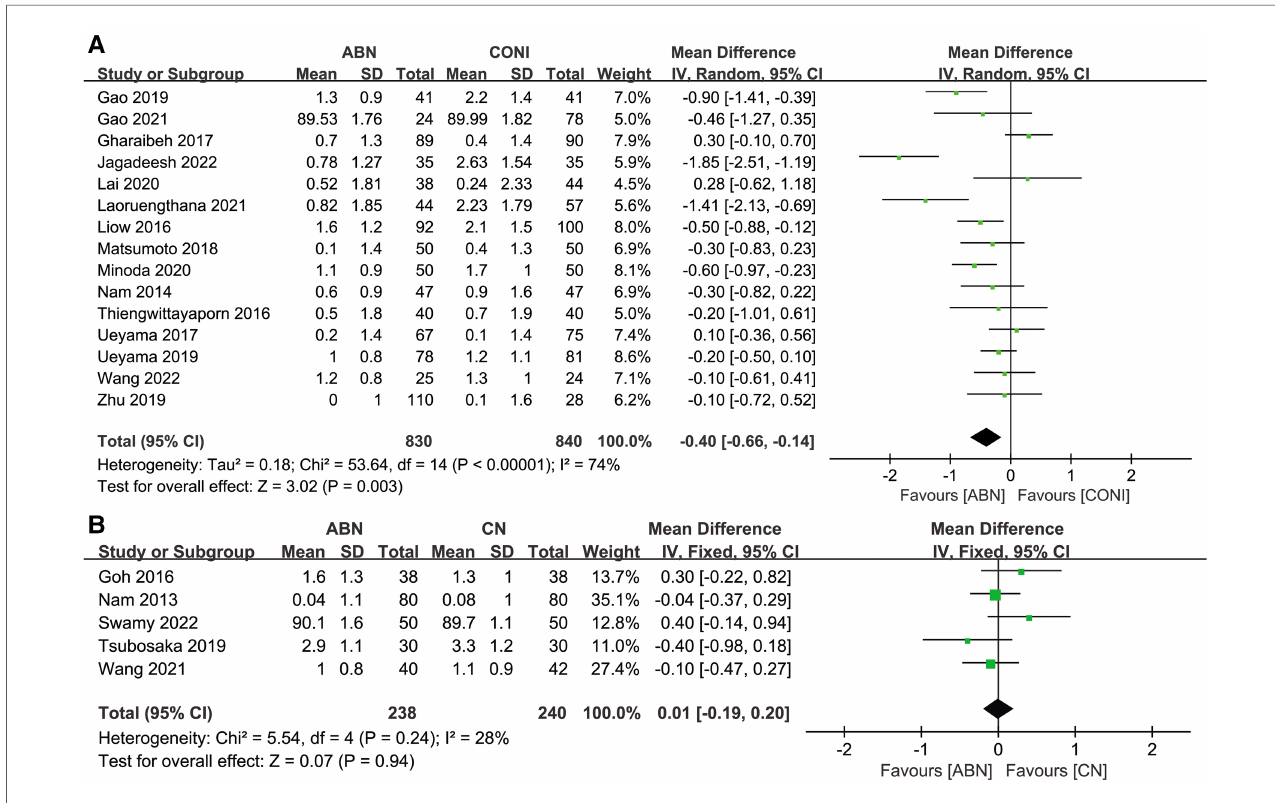
FIGURE 7 Forest plot of coronal tibial angle (CTA). ( A ) Accelerometer-based navigation (ABN) system vs. conventional instrumentation (CONI); ( B ) ABN system vs. computer navigation (CN)